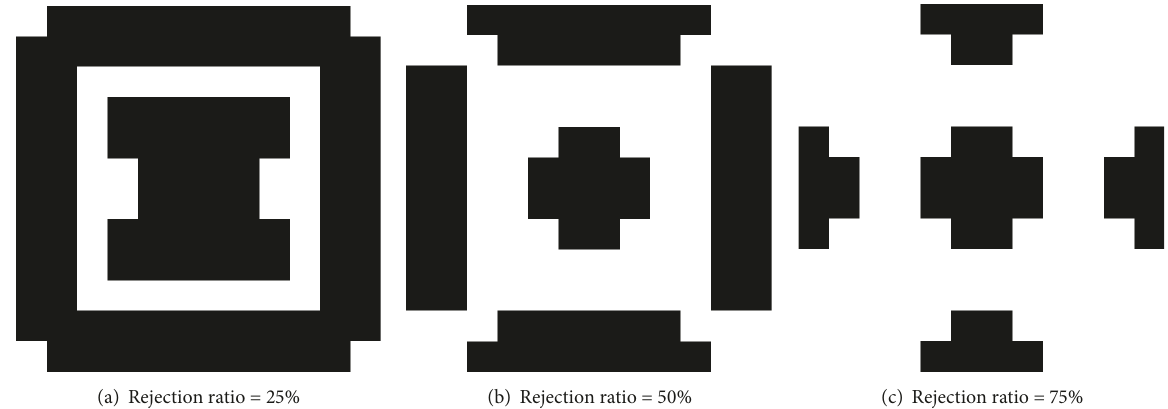
Figure 18: Optimal layouts of CLD treatments under exciting force at point 1 for first BC.